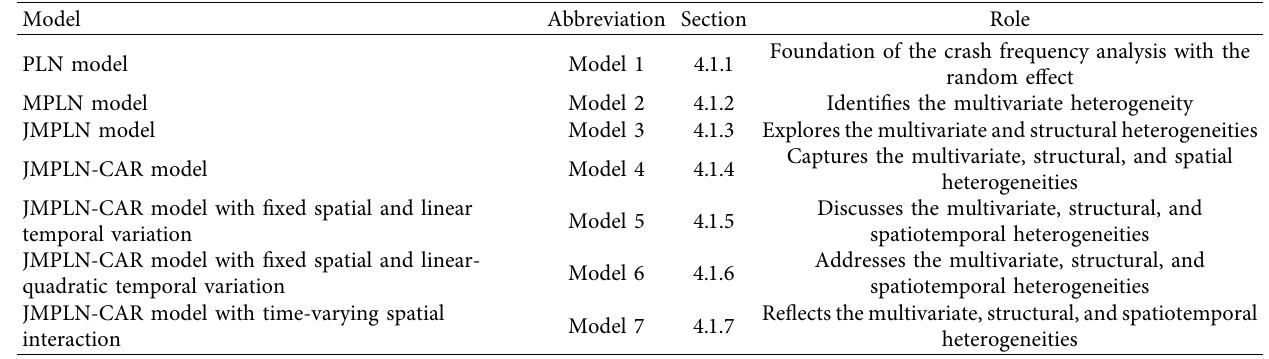
Table 2: Summary of employed